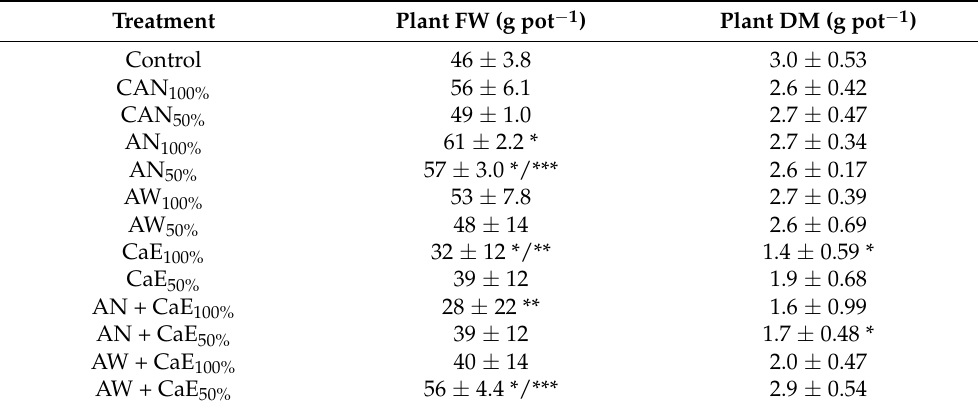
Table 5. Mean plant fresh weight (FW; g pot − 1 ) and dry matter (DM; g pot − 1 ) of tested treatments with standard deviation (n = 4).